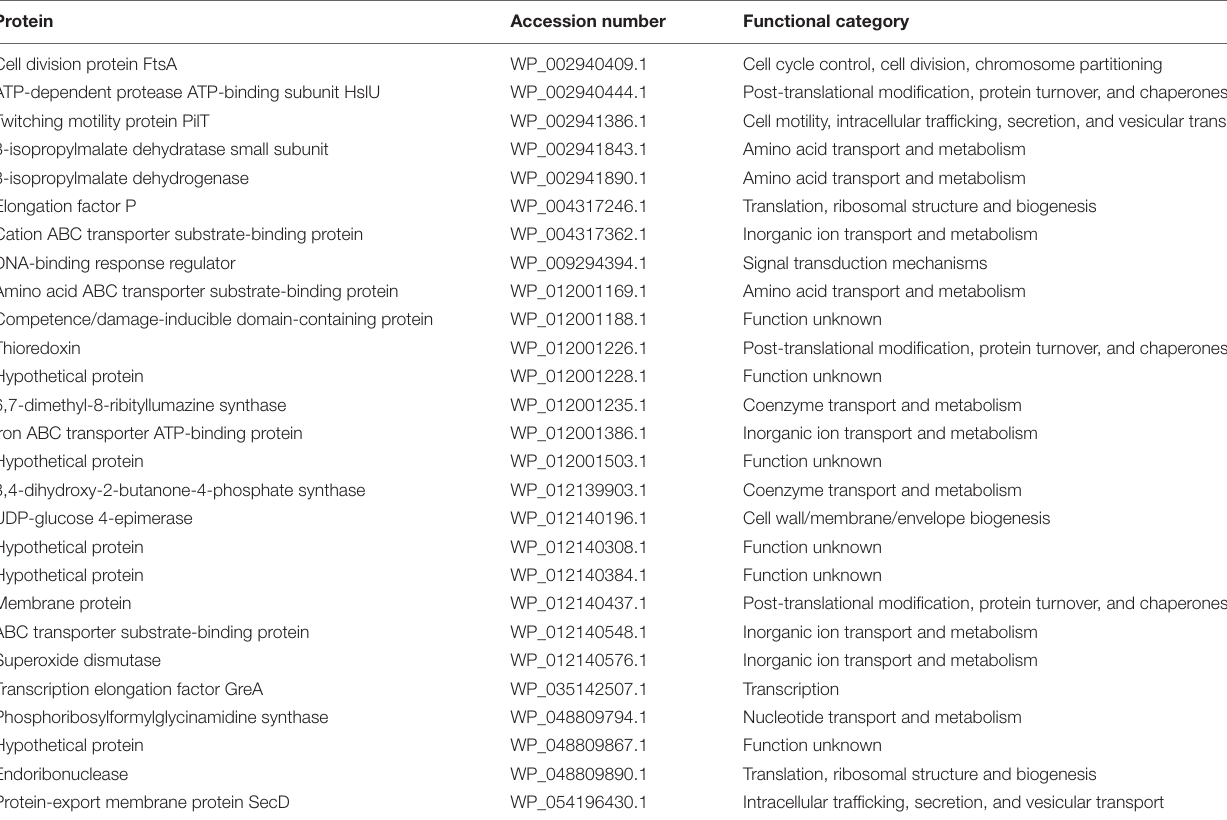
TABLE 5 | Proteins only identified in C. concisus 13826 when cultured on HBA fum0 . 4 .